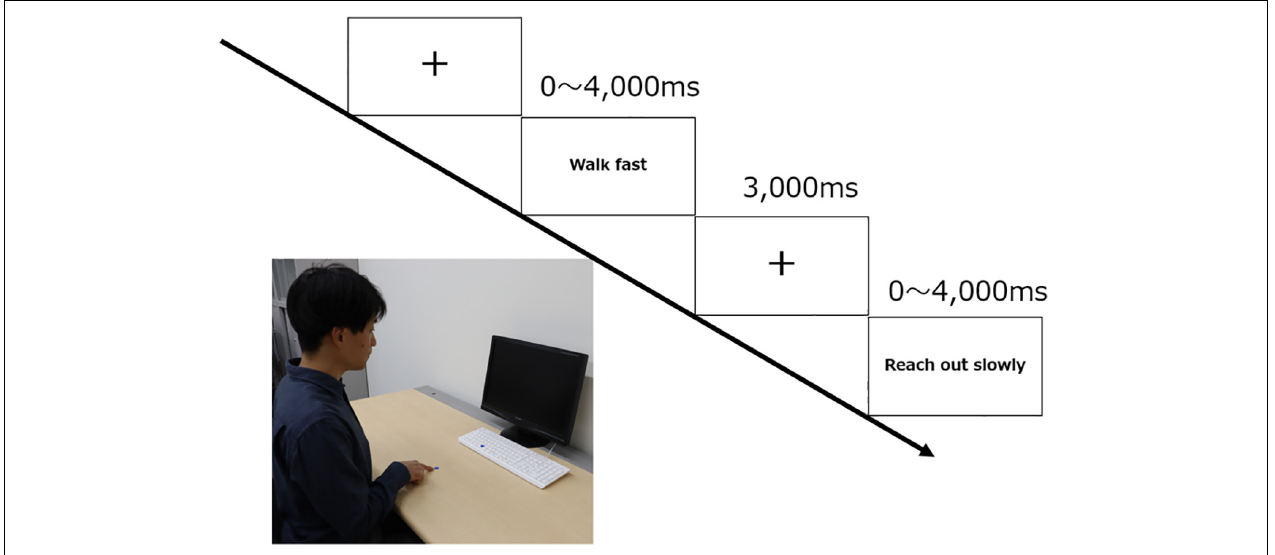
FIGURE 1 | Experiment protocol followed during the study. Participants placed the index finger of their right hand on a mark 20 cm away from the keyboard. A sentence was presented at random, and the participant was instructed to press the button only if they understood the sentence.